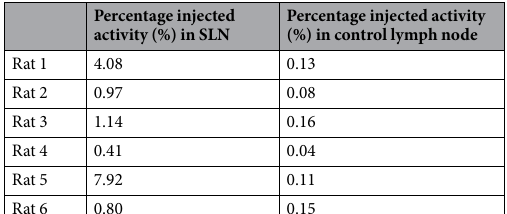
Table 1. Percent injected activity in sentinel lymph node and in the contralateral lymph node (control) one hour after 68 Ga-labelled SPION injection.